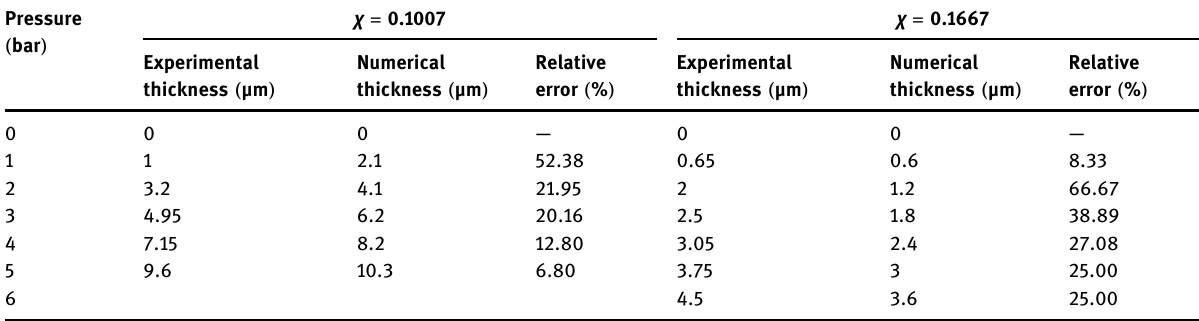
Table 5: Relative error between experimental and model predictions for thickness variation χ = 0.1007 χ = 0.1667 Pressure ( bar )